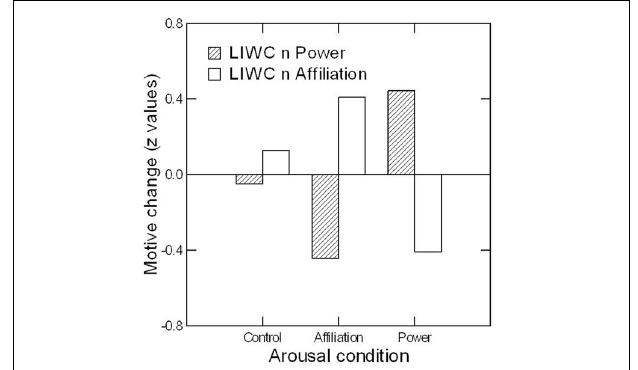
FIGURE 1 | Effect of arousal condition on changes in LIWC-estimated n Power and n Affiliation (postmovie minus premovie z scores) assessed immediately after motive arousal in Study 2 ( n = 10 in each